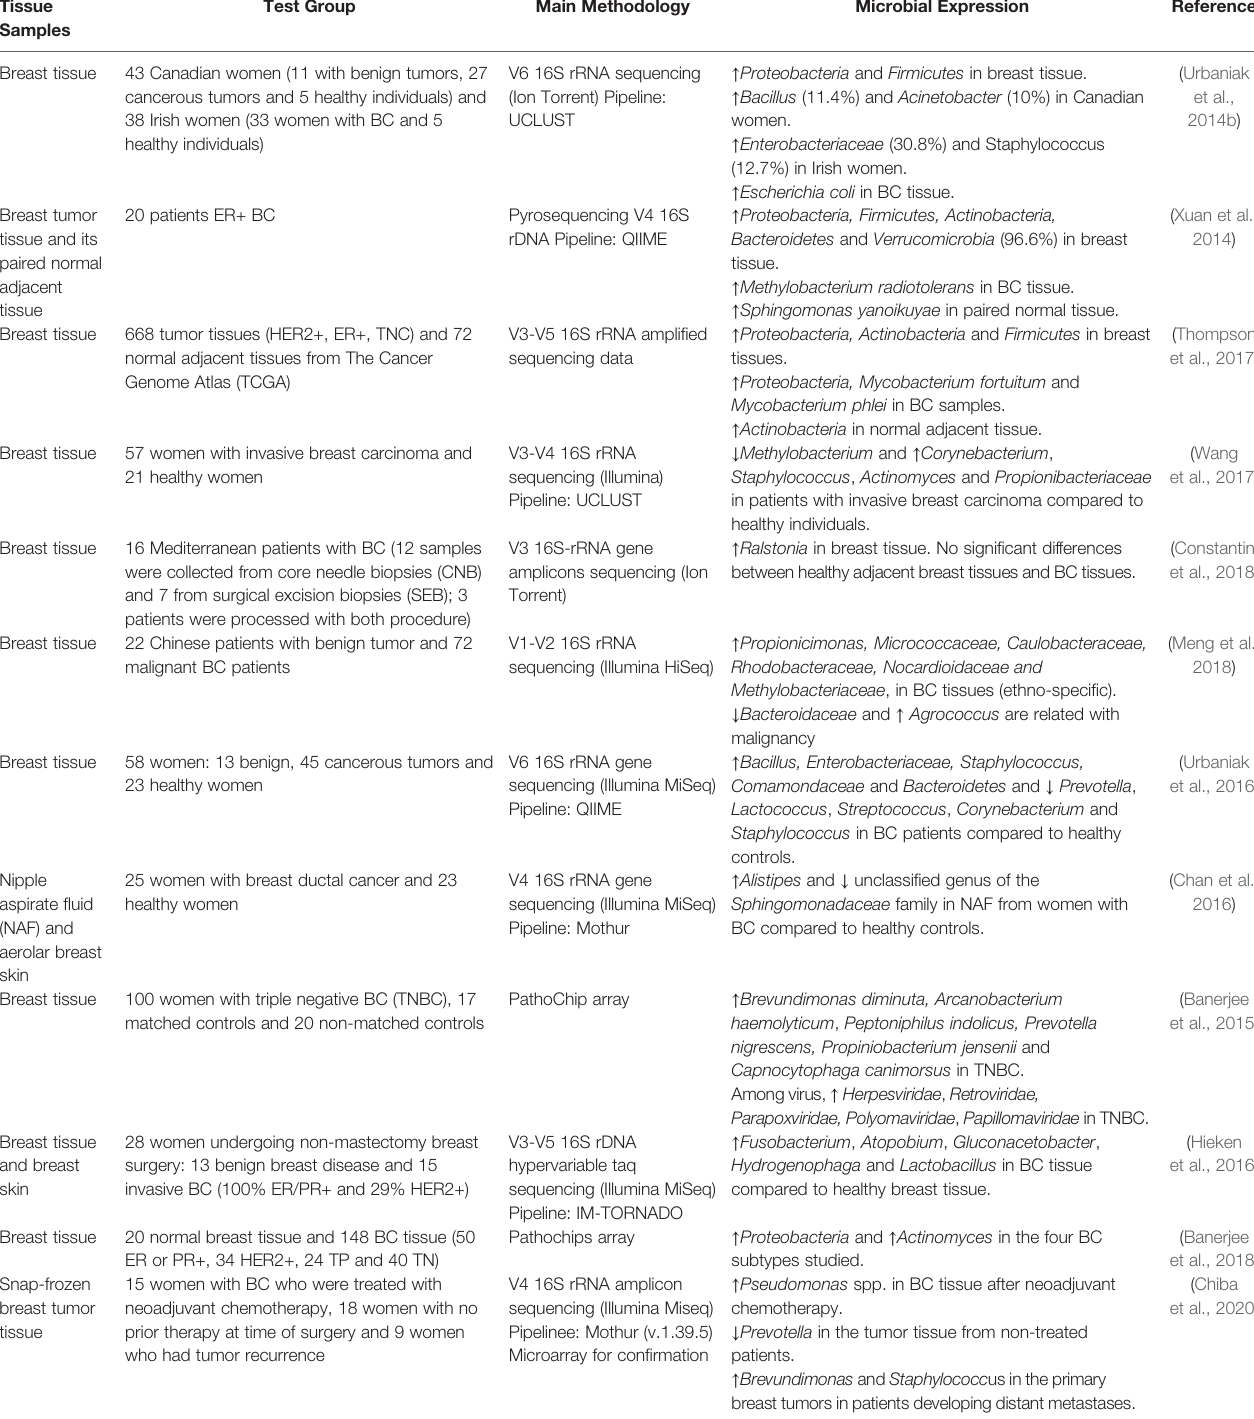
TABLE 1 | Summary of studies about the microbial community in breast tissue. Tissue